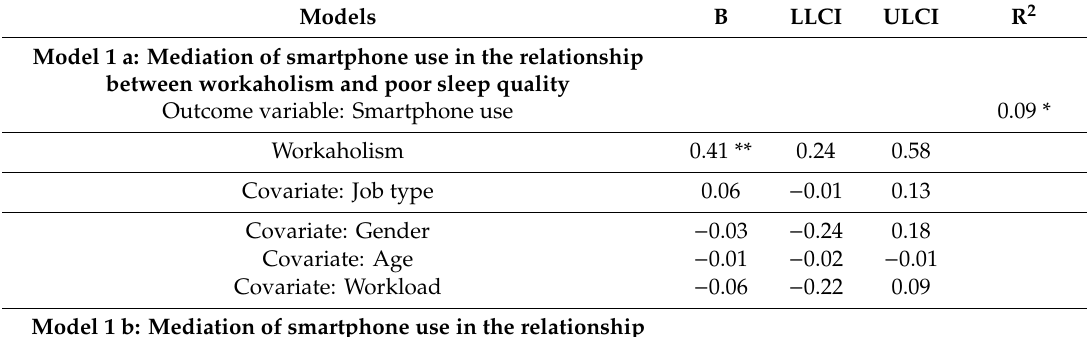
Table 2. Model 1—Results of the direct and indirect e ff ects. Models B LLCI